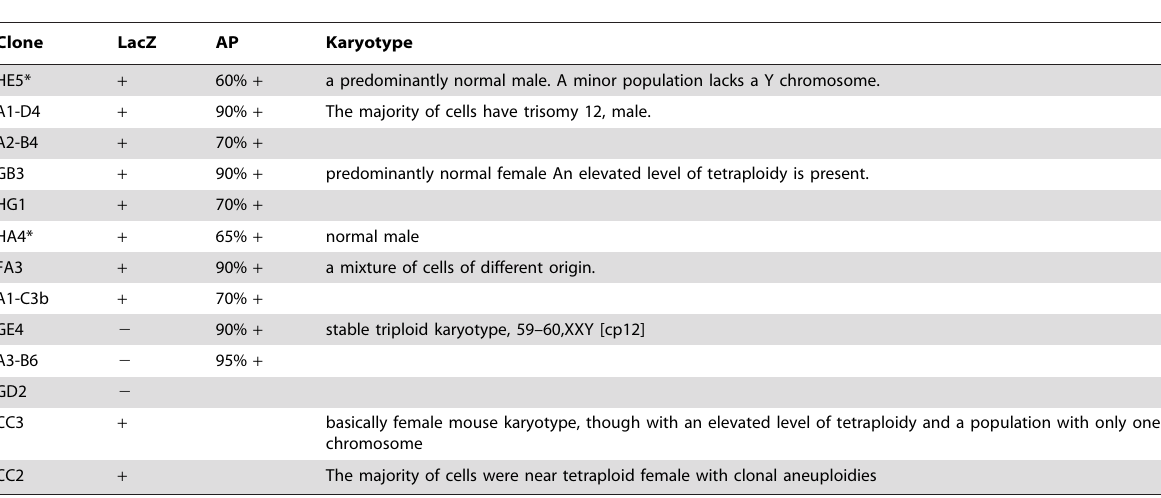
Table 4. LacZ, alkaline phosphatase and karyotype analysis of the mdx ESC clones.